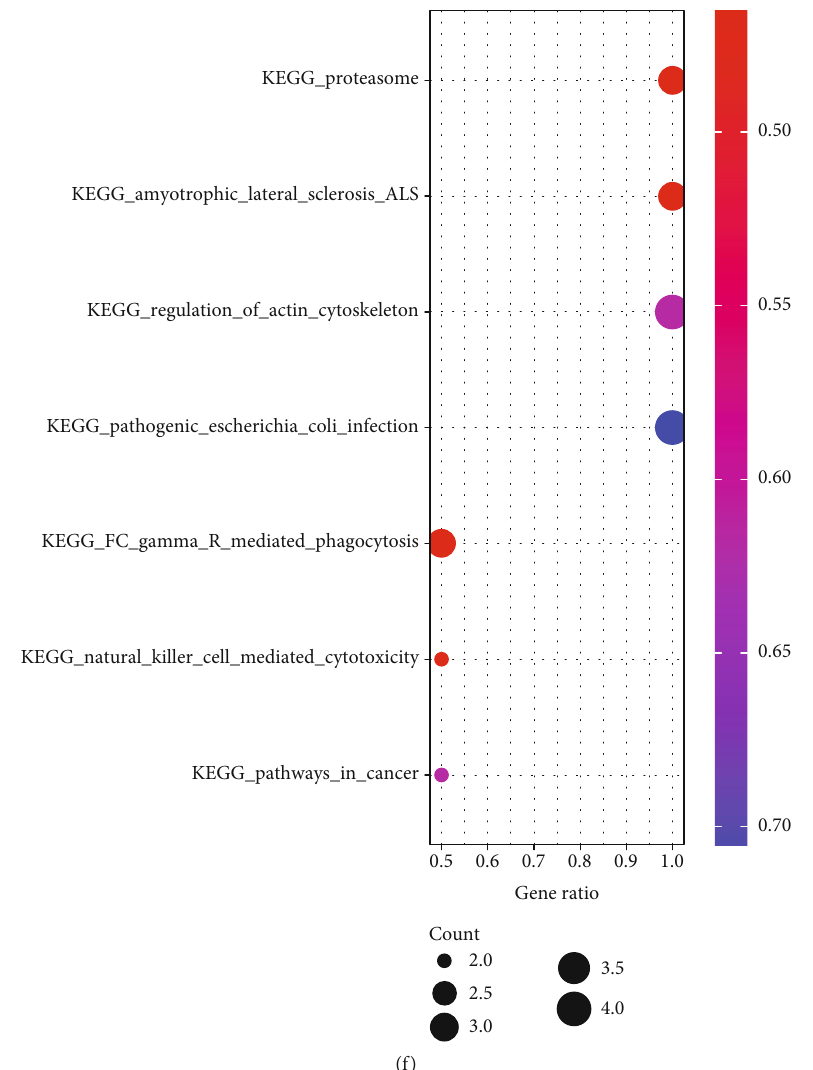
Figure 2: Characterizing the resident and the in fi ltrating monocyte/macrophage. (a) UMAP plot explored 8 clusters after the removal of B cells. (b) Clusters were annotated with known markers for T cells (3) ,NKT cells (0), and monocyte/macrophage cells (1, 4, and 6) .(c) The cell clusters from the healthy and rejected kidney tissues were compared for individual samples. (d) Bar plot shows the frequency of each cluster of the healthy and rejection samples. The marker genes of clusters 1 (e) and 6 (f) were classi fi ed for their involvement of KEGG signaling pathways in clusters 1 and